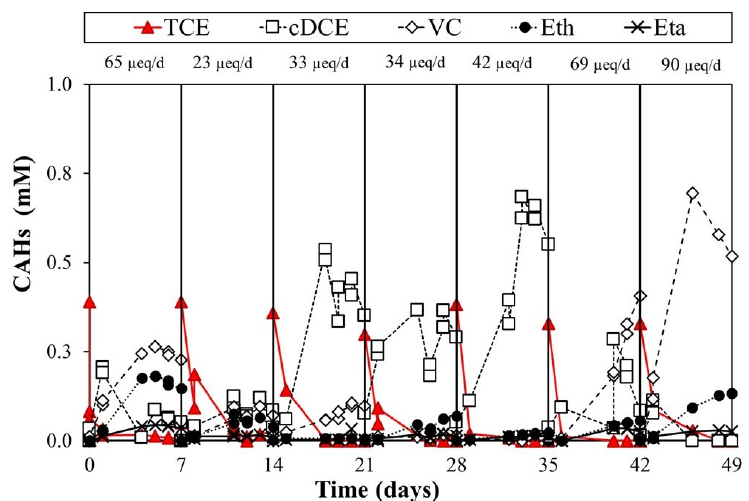
Figure 5. Bioelectrochemical system monitoring. The weekly cycles and RD rates (µeq/d) values, calculated according to Equation (1), are evidenced.